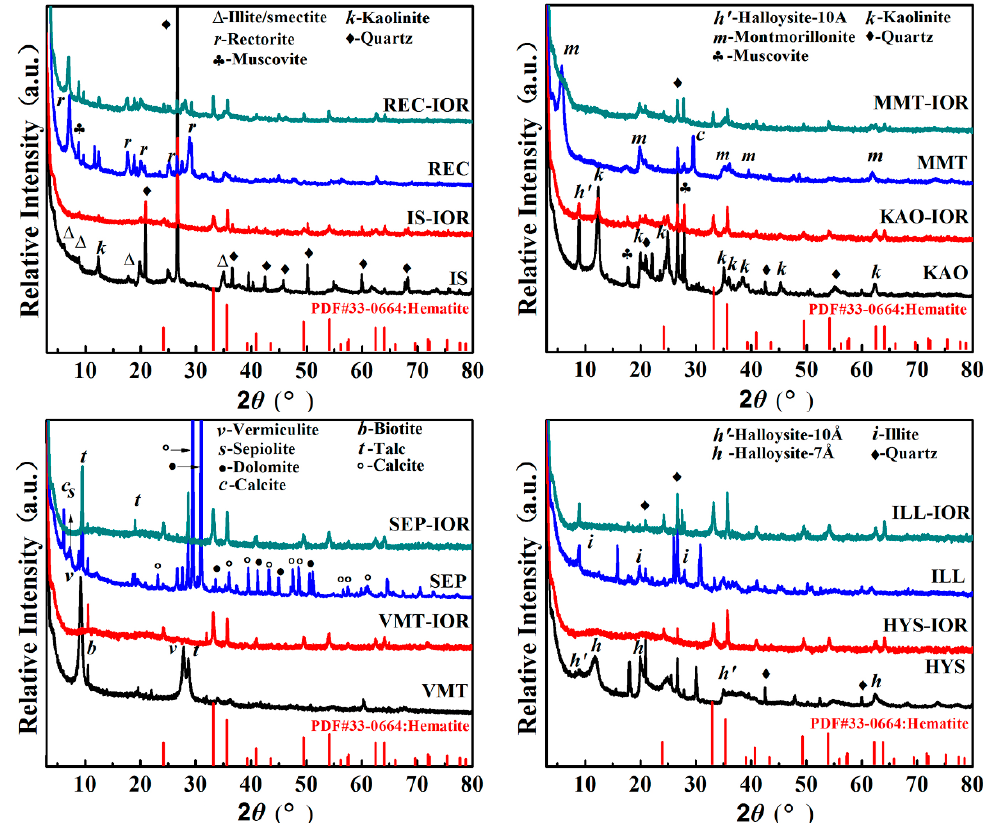
Figure 1. XRD patterns of selected natural clay minerals and the corresponding hybrid pigments.